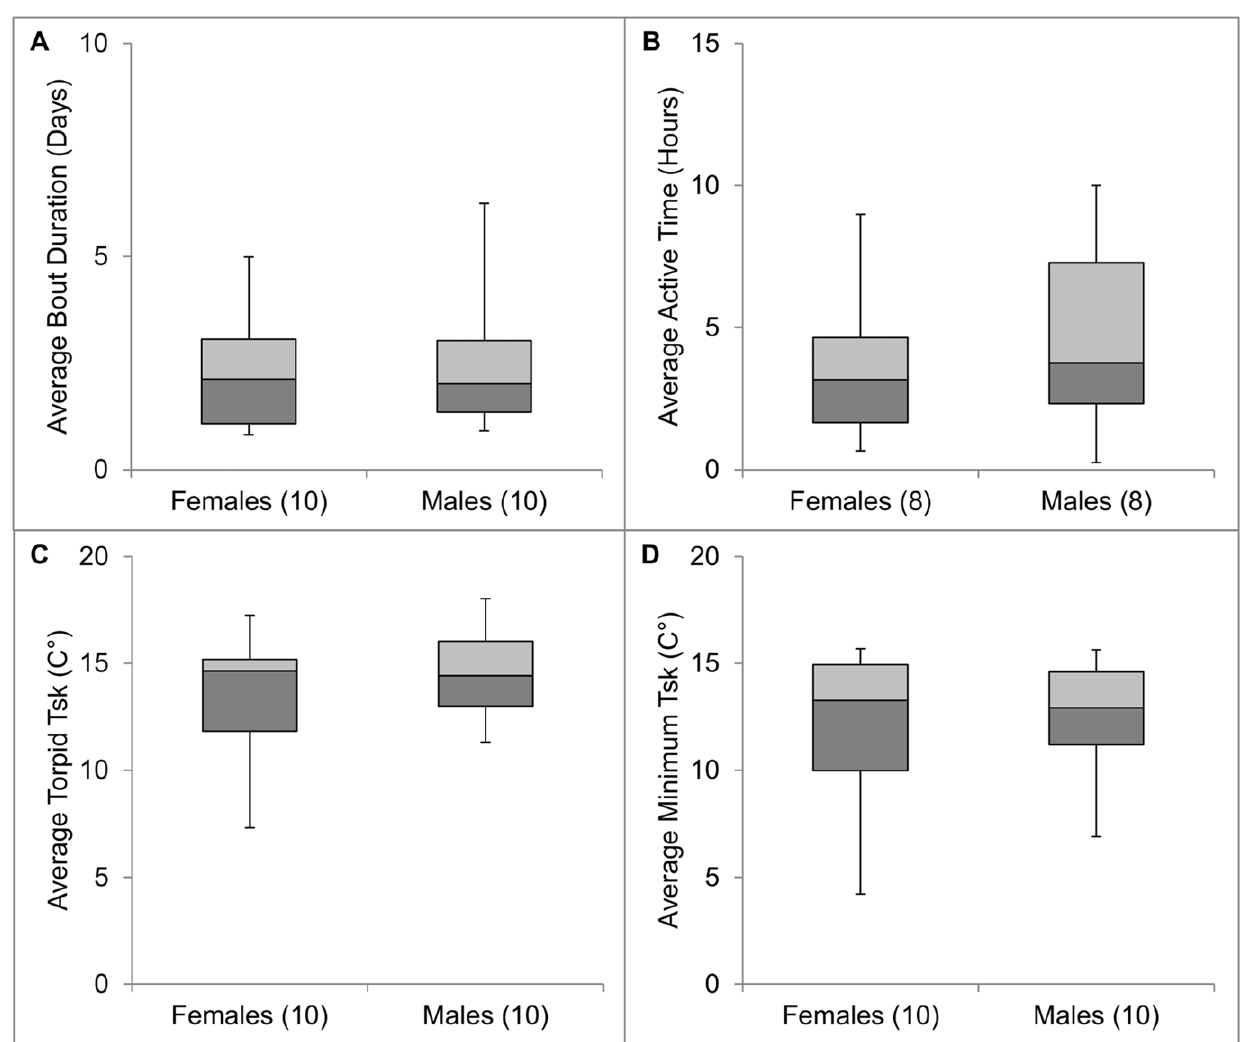
Figure 1. Winter torpor behaviors of male and female Rafinesque’s big-eared bats determined through radio-telemetry at Mammoth Cave National Park, Kentucky, USA. Number of radio-tagged bats is included in parentheses.